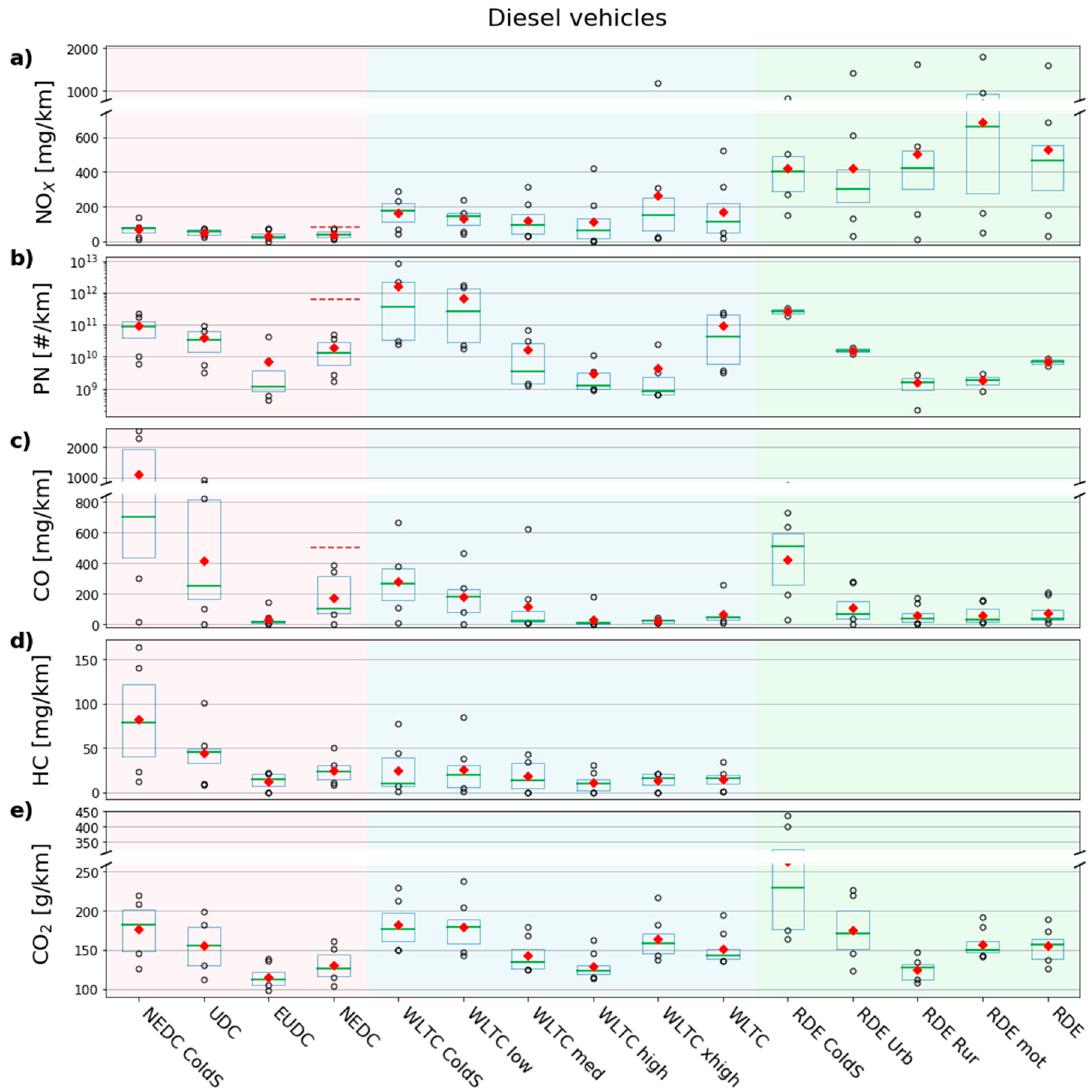
Figure 3. Boxplot of emission factors of the diesel sample for NEDC, WLTC, and RDE phases and their respective cold start ( a ) NO X [mg / km], ( b ) PN [# / km], ( c ) CO [mg / km], ( d ) total hydrocarbons (HC) [mg / km], and ( e ) CO 2 [g / km]. The box represents the 1st and 3rd quartile, the green line is the median, the red diamond is the mean, and the black circles are data points beyond the interquartile range. The brown dashed lines represent the Euro 6 emission limit at type approval for diesel vehicles over the NEDC cold test for NO X [80 mg / km], PN [6 × 10 11 # / km], and CO [500 mg / km]. Note that in ( a ), ( c ), and ( e ) the y -axis is broken in two sections and in ( b ) y -axis it is logarithmic. The average PN EF of the diesel fleet on UDC was 3.9 × 10 10 ± 2.9 × 10 10 # / km almost 20 times higher than over the EUDC (Figure 3b). The di ff erence can be explained by the large contribution of the emission on the first five minutes of the test which reached on average 9.2 × 10 10 ± 6.9 × 10 10 # / km. The low phase of WLTC was also the phase with the highest PN for all vehicles with an average emission of 6.5 × 10 11 # / km. Again, emissions released during the cold start explained the larger emissions of the low phase. PN emissions over the cold start of the WLTC averaged 1.6 × 10 12 ± 2.5 × 10 12 # / km which is three orders of magnitude higher than the average PN over the high and extra-high phases. The urban bin of the RDE tests exhibited emissions of 10 10 # / km whereas over the rural and motorway, PN values were in the order of 10 9 # / km. PN emissions associated with cold start averaged 2.6 × 10 11 # /